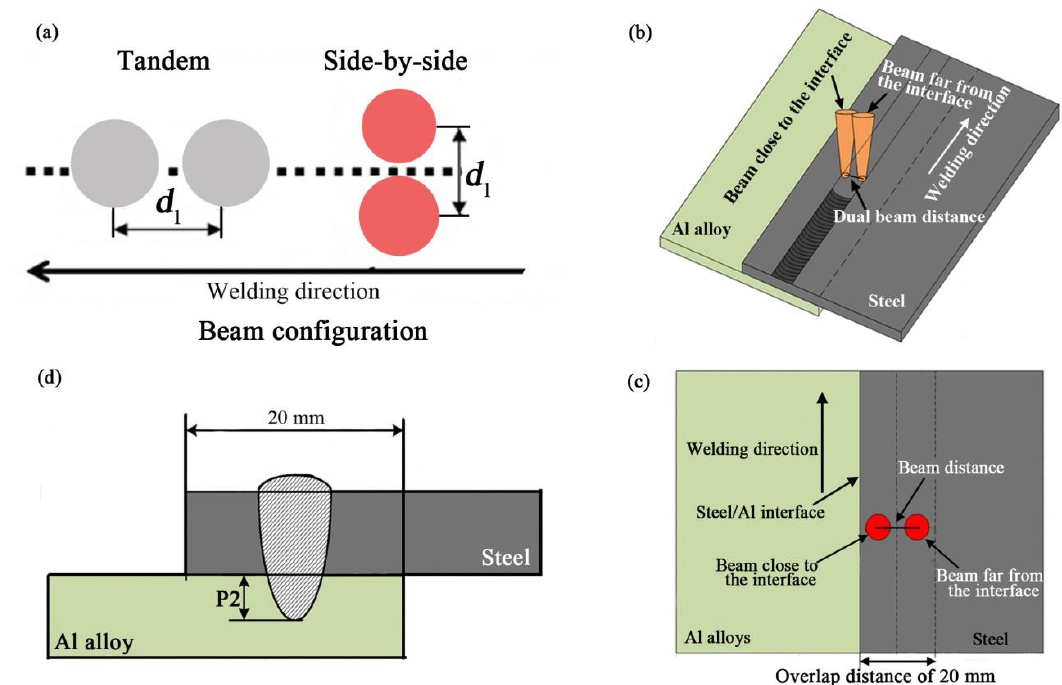
Figure 1. Schematic diagram of dual-beam laser welding of steel/Al joints: ( a ) Tandem beam and side-by-side configuration [28,30]; ( b ) Setup of the side-by-side configuration; ( c ) Main processing parameters with side-by-side configuration; ( d ) Dimension of the cross section of the welds.